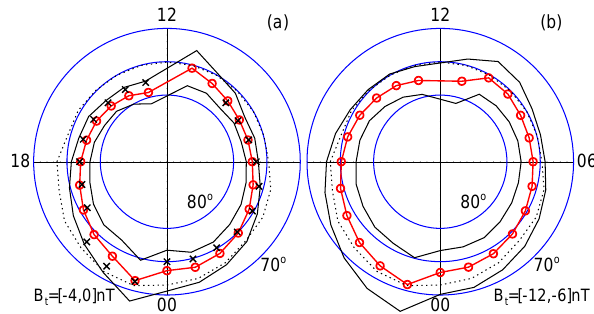
Figure 3. Typical location of the convection reversal boundary (CRB) in the MLT-MLAT coordinates, red dots, for IMF B − t in be- tween (a) − 4 and 0nT and (b) − 12 and − 6nT. Data for 1995–2013 were considered without binning according to the IMF B y . Shown by the solid line is the CRB location ± 1 standard deviation from the inferred typical location. The dotted line is the CRB location reported by Bristow and Spaleta (2013) for a case of no binning ac- cording to the IMF (except considering only B z < 0 data), scaled from their Fig. 7. Crosses are the CRB location according to the RG-96